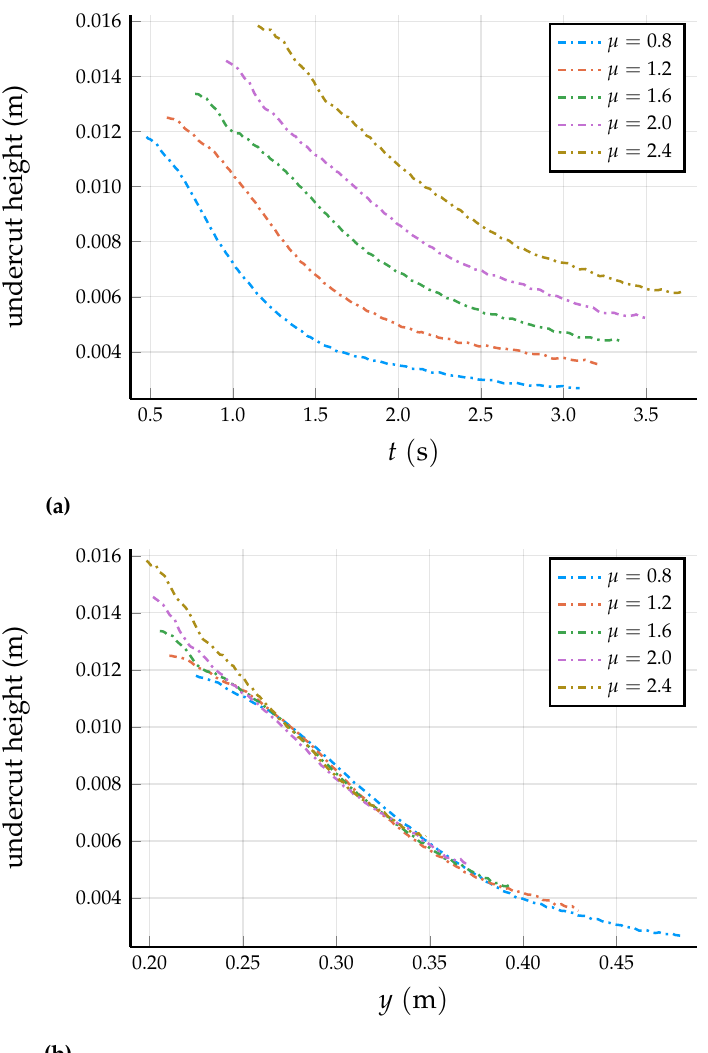
Figure 7. ( a ) Undercut heights plotted from peak value as a function of time. Shifting of the peaks is largely due to the start times calculated by Equation (33). ( b ) Undercut heights plotted from peak value as a function of space. In all cases, only µ is varied and no interfacial effects are present.